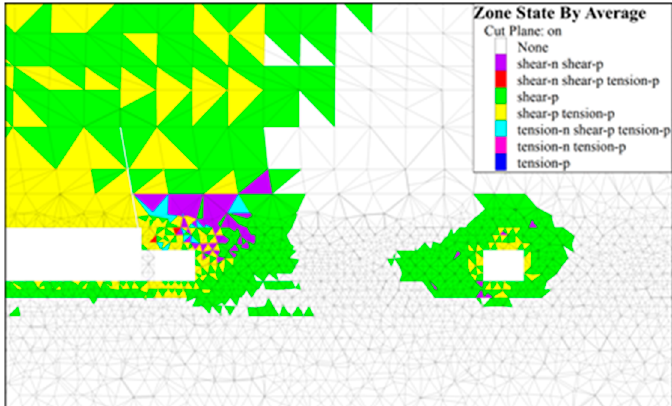
Figure 14. Plastic development of surrounding rocks after roof cutting.